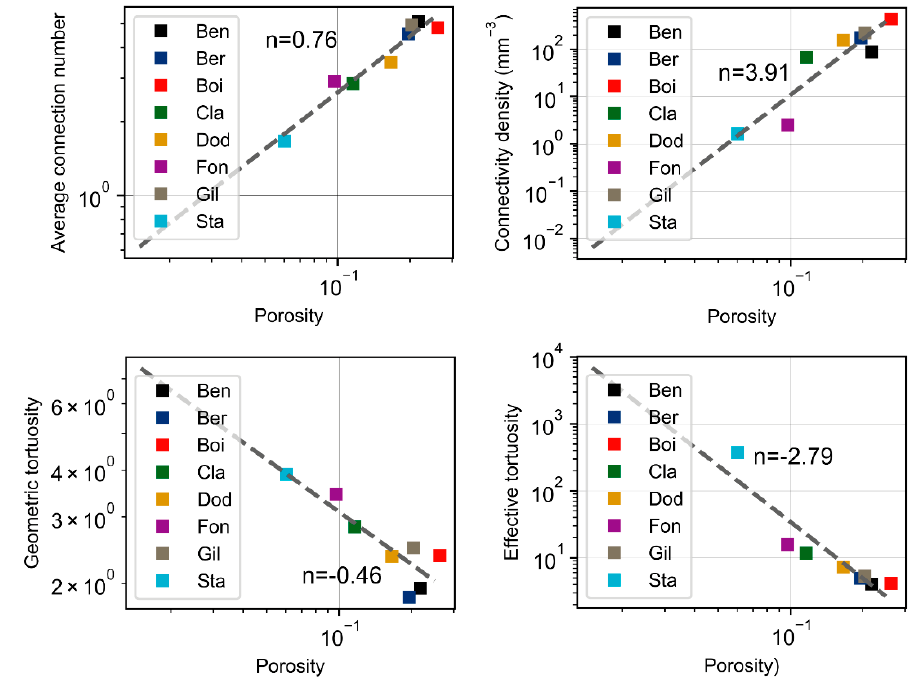
Figure 11. The log–log plots of average coordination number, connectivity density, geometric tortuosity and effective tortuosity as a function of porosity.